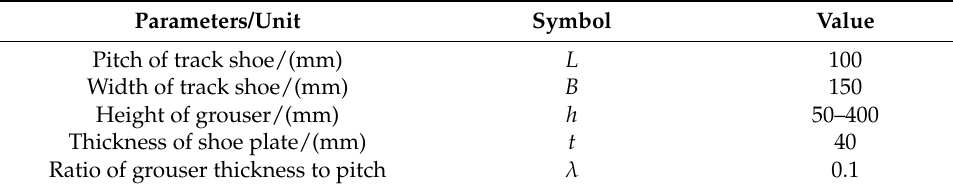
Table 2. Dimension details of the single-grouser-track shoe